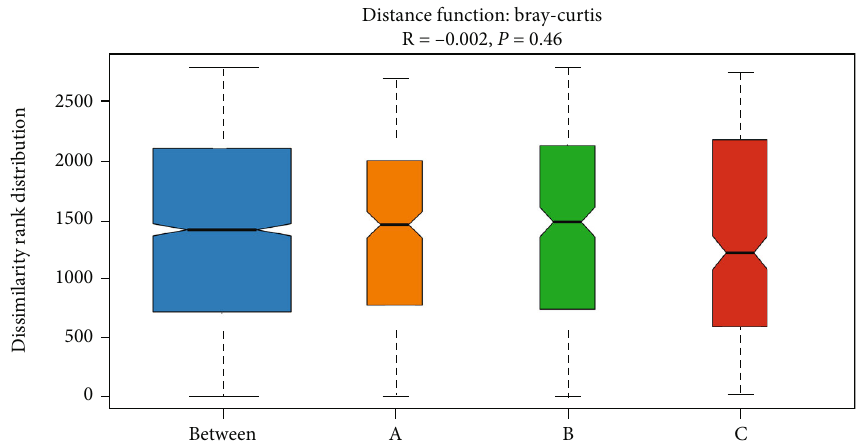
Figure 5: Dissimilarity rank distribution. Comparison of the gut microbial community composition between groups A, B, and C using analysis of similarities